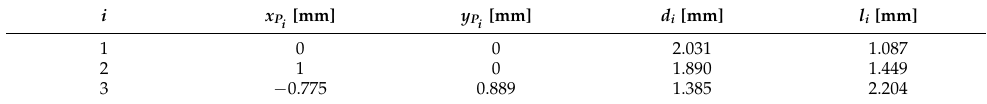
1,2,3 ) and link lengths for a 3-RR structure whose DKP Table 1. Coordinates of fixed points P i ( i ∈ { } has 12 real and distinct solutions. Without loss of generality, points P 1 and P 2 are taken respectively at the coordinate-system origin and on the x axis; the other values in the table are found by optimization.